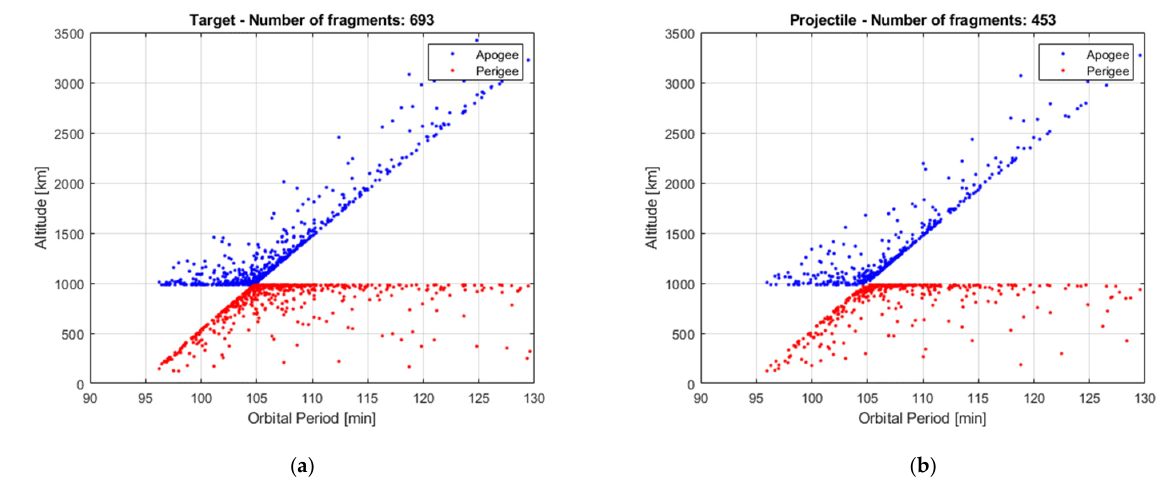
Figure 10. Gabbard diagrams for the target ( a ) and the projectile ( b ), obtained with input masses equal to m 1 = 850 kg and m 2 = 490 kg.